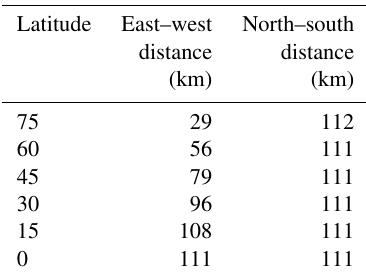
Table 2. Selected latitudes and the length dimensions of 1 ◦ in as- sociated raster cells. The values shown are symmetric about the equator. CDIAC locates its raster borders on 1 ◦ lines of latitude and longitude. Other maps may center their raster cells on these lines and are thus offset from the CDIAC grid by 0.5 ◦ . Calcula- tions based on WGS84 ellipsoid data from http://earth-info.nga.mil/